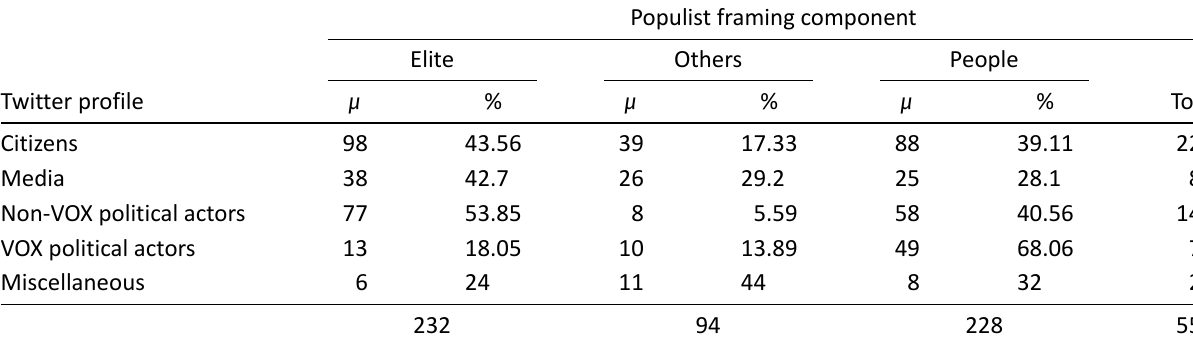
Table 4. Populist frames used by Twitter profiles.